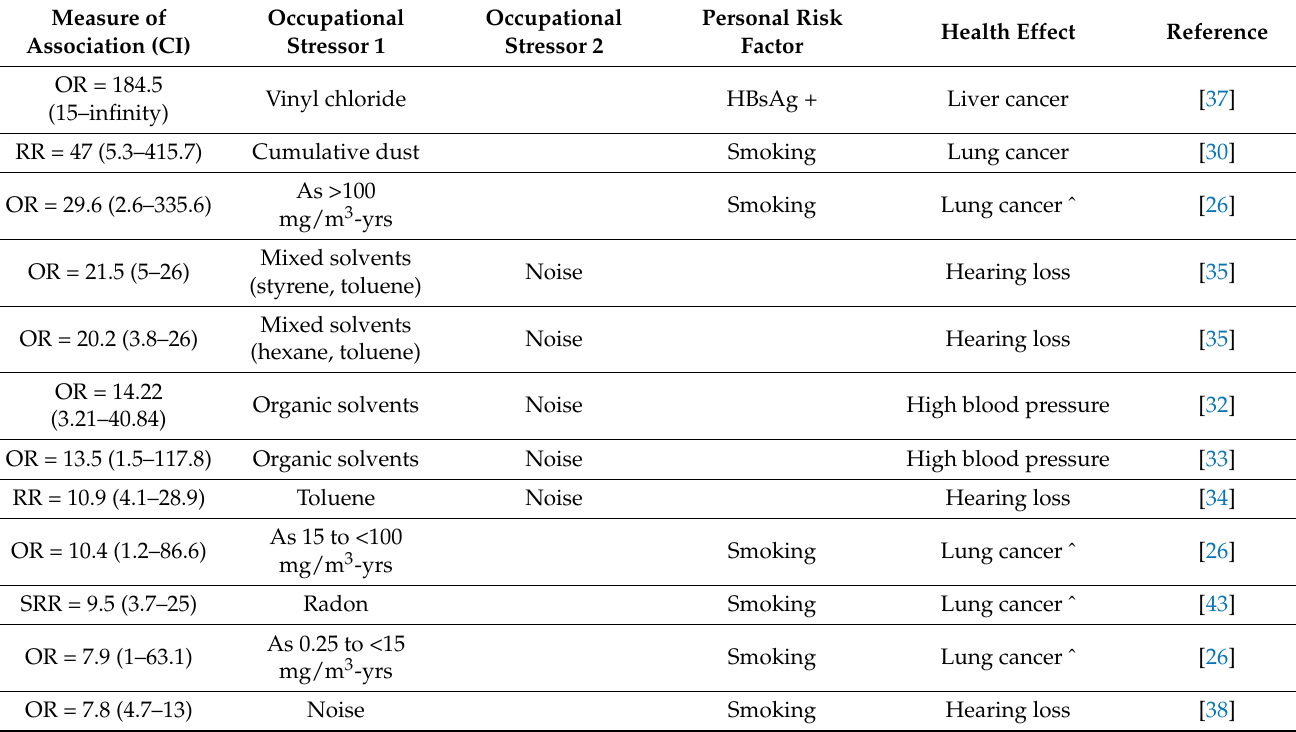
Table 2. Studies ranked by magnitude of risk (high to